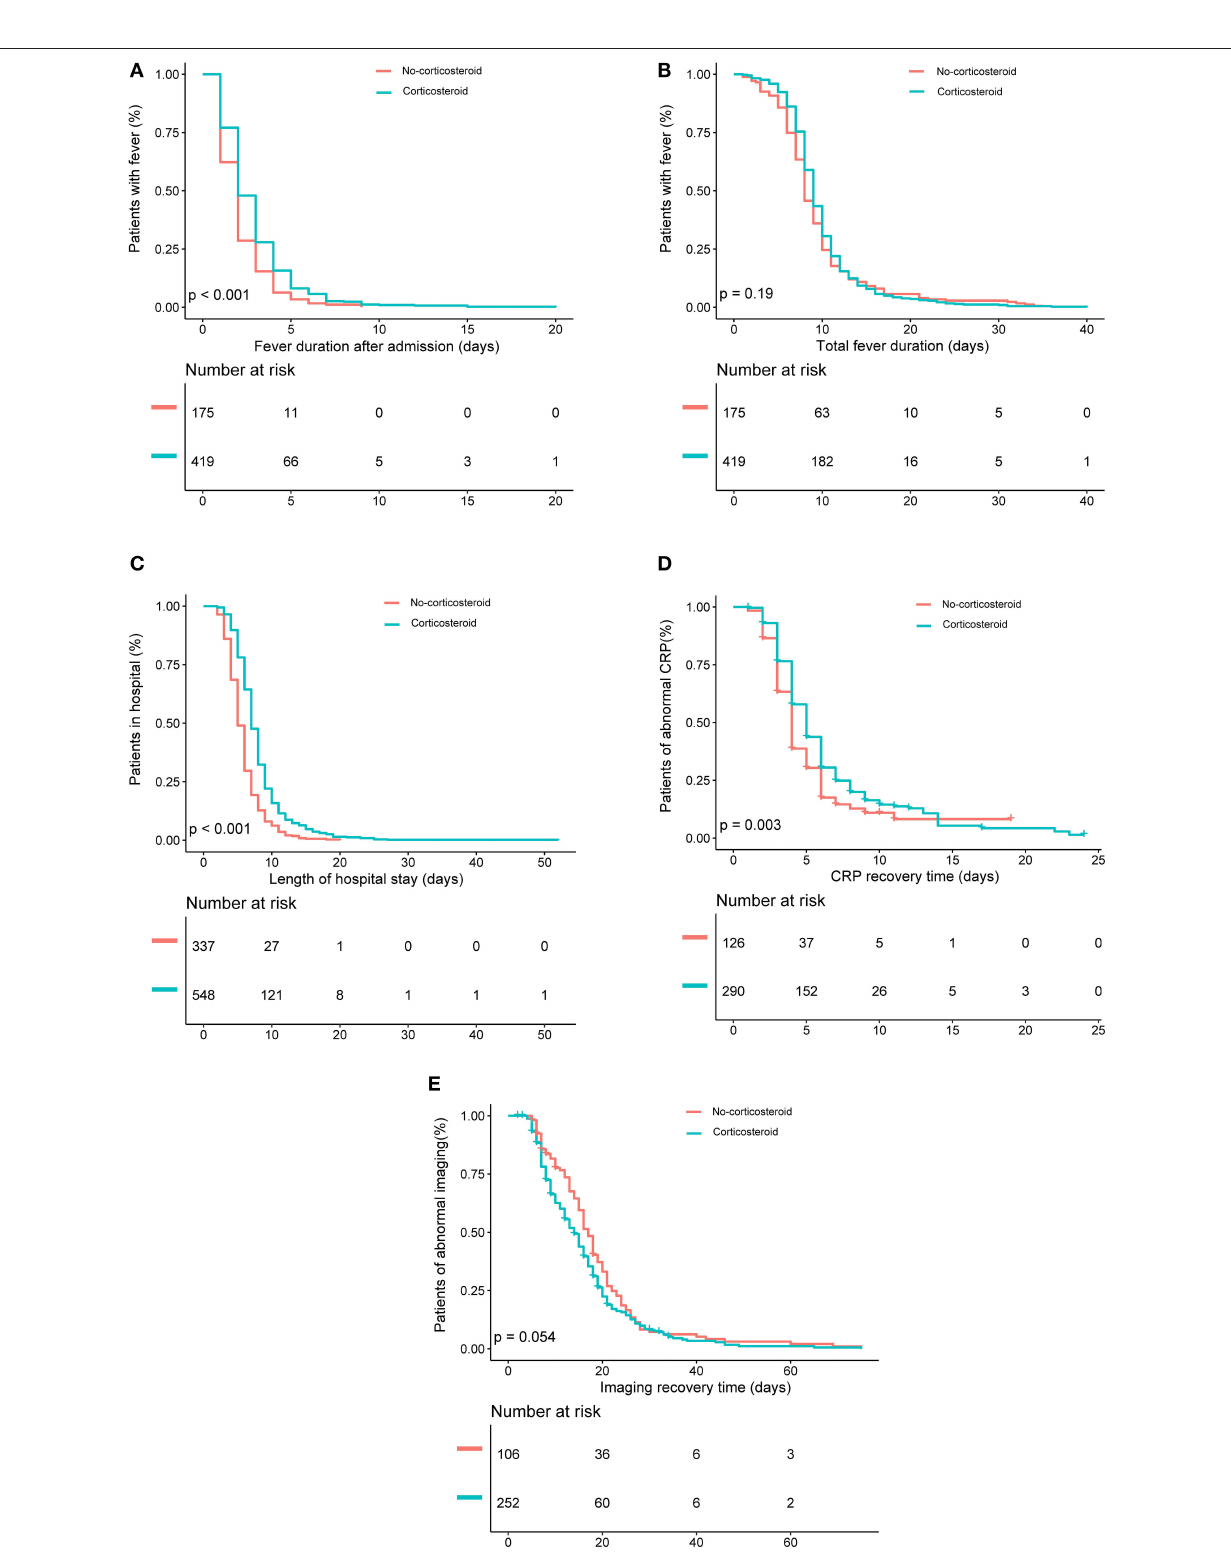
Frontiers in Pediatrics |